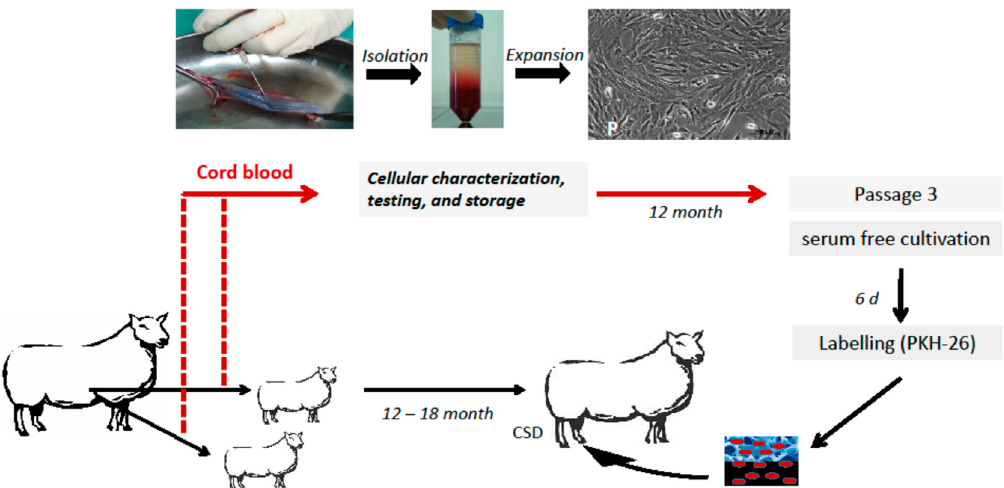
Figure 7. Experiment design of the test group: autologous implantation of labeled USSC into the tibial bone defect. Ovine USSC were obtained, isolated; expanded, characterized by flow cytometry, and frozen. After 12 months, full-size 2.0 cm mid diaphyseal bone defects were created in the right tibia of adult sheep. Autologous USSC of the third passage were thawed, labeled with the membrane dye PKH-26 and 2 × 10 7 cells were seeded onto four hydroxyapatite (HA) blocks and implanted into the defect.